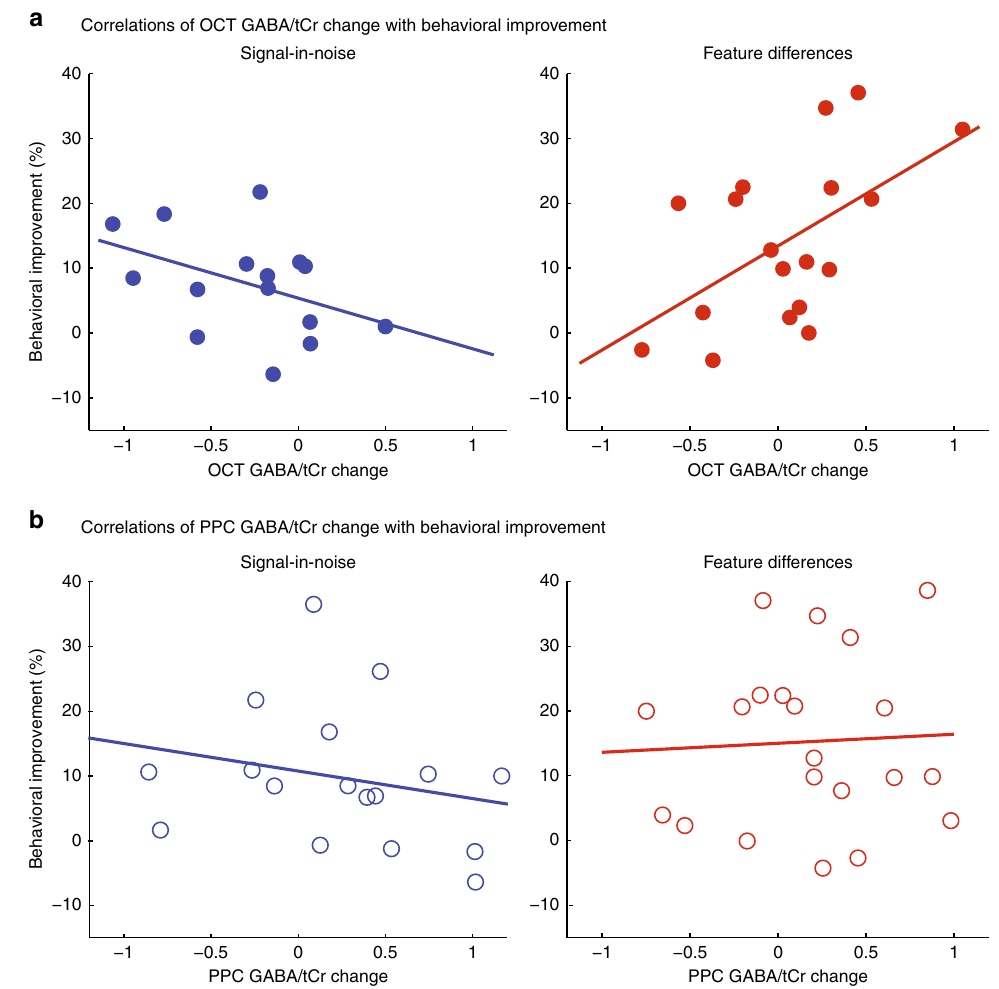
Fig. 4 Correlating γ -aminobutyric acid (GABA) change with behavioral improvement. a Skipped Pearson ’ s correlations showing a signi fi cant negative correlation of GABA/tCr change in occipito-temporal cortex with behavioral improvement for the signal-in-noise task ( n = 16, r = -0.43, CI = [ – 0.75, – 0.002]), whereas a signi fi cant positive correlation for the feature differences task ( n = 19, r = 0.55, CI = [0.10, 0.78]). We computed GABA/tCr change for each participant as the difference between GABA/tCr in the training block with maximum performance and GABA/tCr in the baseline block. Note that the temporal resolution of GABA measurements does not allow us to separate the different processes associated with different events in a trial (e.g., stimulus vs. response). Thus, the correlations we report here relate learning-dependent changes in GABA levels to learning-dependent changes in overall task performance. The plots indicate that for a small number of participants the data deviated from the overall pattern of the correlation; e.g., for some participants in the SD task, GABA/tCr values were higher rather than lower compared with baseline. Our treatment of the data (i.e., GABA data are expressed as percent over baseline; behavioral improvement is expressed as percent over early performance) accounts for potential differences across participants in performance early in training or baseline GABA before training. It is possible that this individual variability was due to the single training session employed in our study during which participant performance did not saturate (i.e., average 72% maximum performance across participants). b Correlations of posterior parietal GABA/tCr change from baseline with behavioral improvement were not signi fi cant for the signal-in-noise ( n = 17, r = – 0.23, CI = [ – 0.61, 0.19]) or the feature differences task ( n = 21, r = 0.05, CI = [ – 0.37, 0.43]). Signi fi cant correlations are indicated by closed symbols; nonsigni fi cant correlations by open GABA and Task ( F (1, 33) = 2.33, p = 0.14), suggesting that this regression model with baseline PPC GABA and Task as predictors of behavioral performance ( fi rst training block) showed a signi fi cant effect of PPC GABA ( F (1, 37) = 4.69, p = 0.04), but no interaction between PPC GABA and Task ( F (1, 37) = 0.03, p = 0.85). This result was con fi rmed by a signi fi cant positive correlation between baseline PPC GABA and performance in the fi rst training block ( r = 0.34, CI = [0.06, 0.59]), suggesting GABAergic inhibition in the parietal cortex before training relates to suppression of task-irrelevant information early in the training across tasks. We did not fi nd a signi fi cant effect of OCT GABA ( F (1, 33) = 2.14, p = 0.15) nor an interaction between OCT